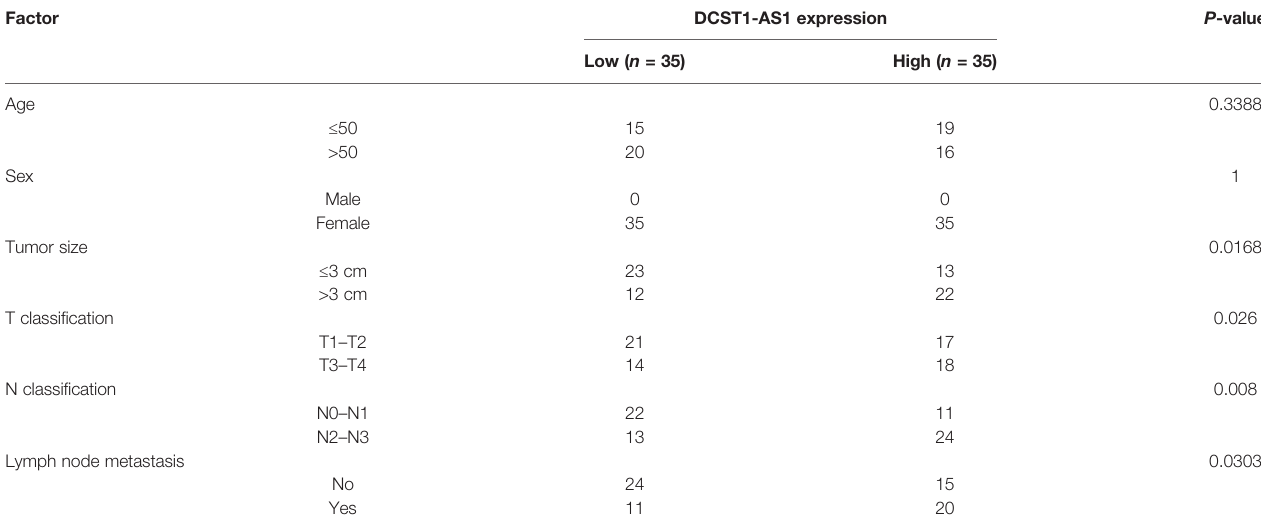
TABLE 2 | Correlation between lncRNA DCST1-AS1 expression and clinicopathological factors in EC.